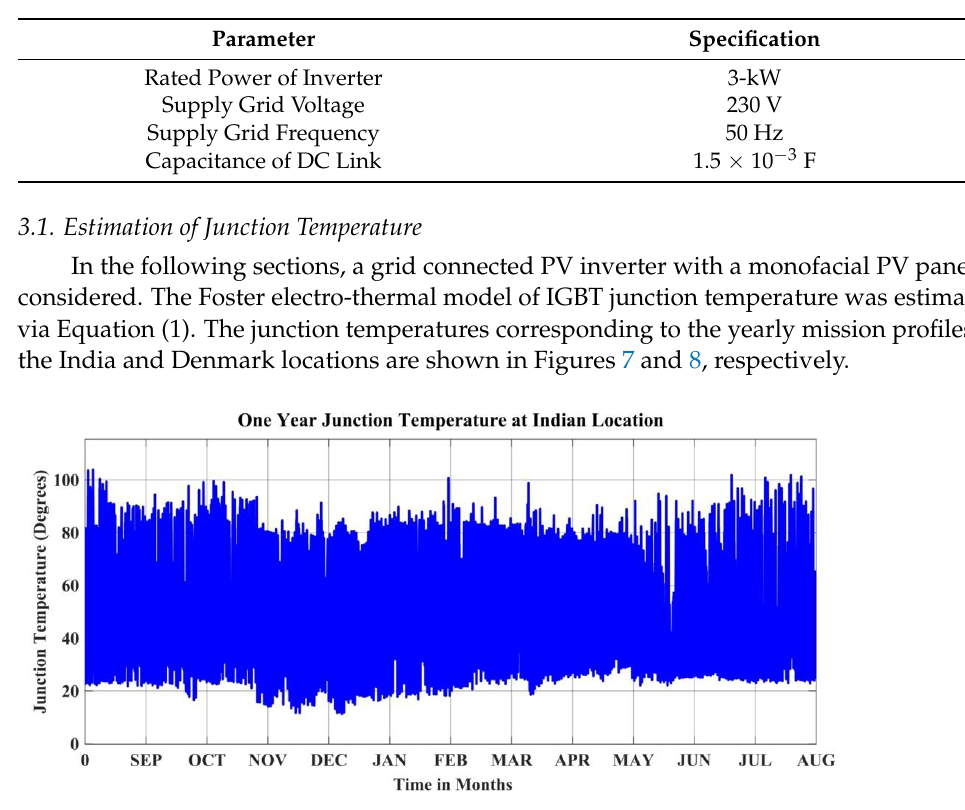
Figure 7. One-year estimated junction temperatures at the location in India.